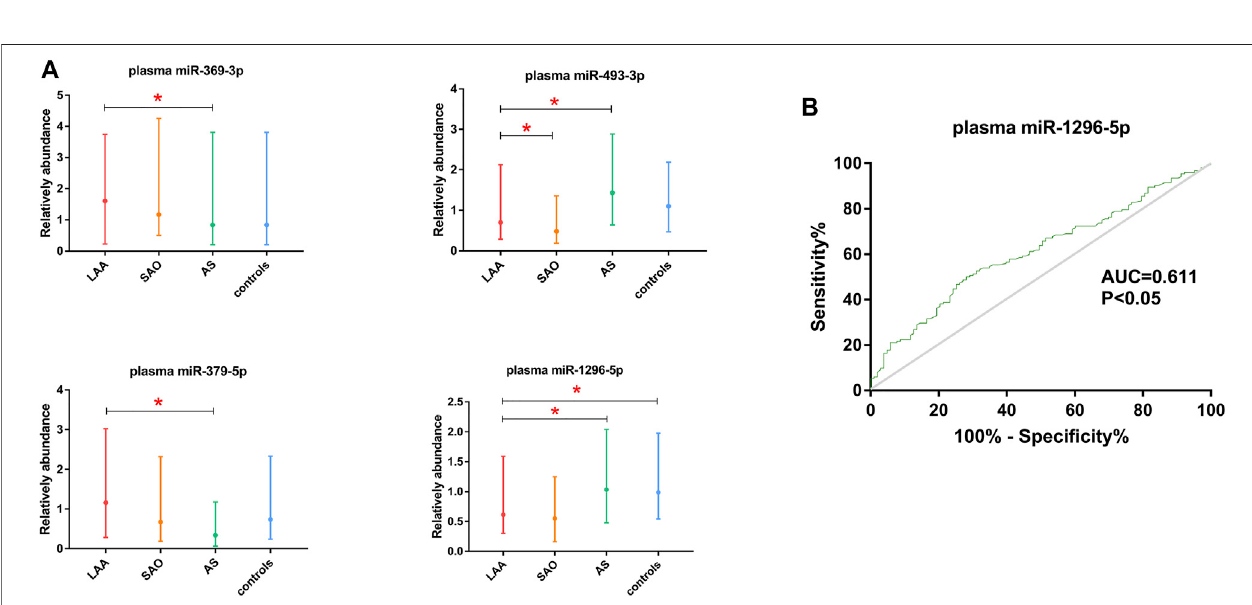
FIGURE 6 | Validation of plasma miR-369-3p, miR-493-3p, miR-379-5p, and miR-1296-5p. (A) . qRT-PCR of miRNAs in plasma. (B) . ROC curve of plasma miR- 1296-5p. The AUC was calculated and is shown in green (* p < 0.05).